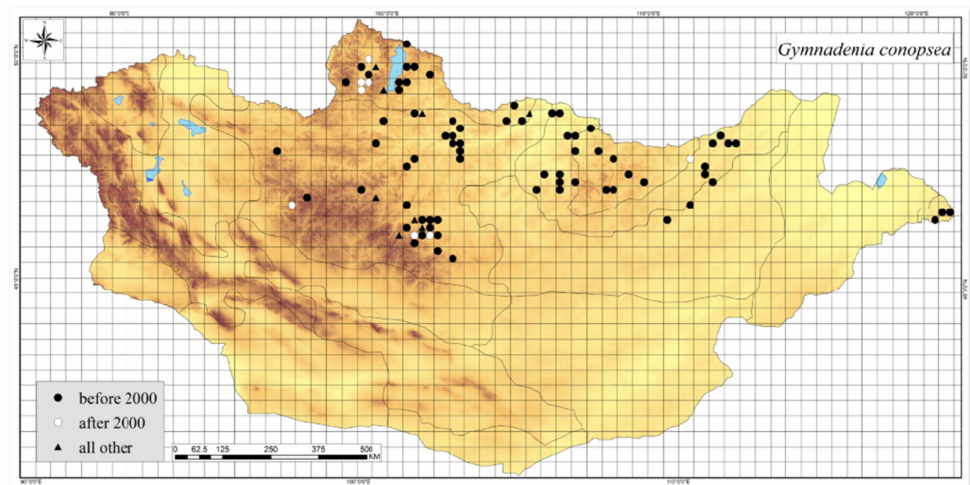
Figure A15. Distribution map of Gymnadenia conopsea in Mongolia.